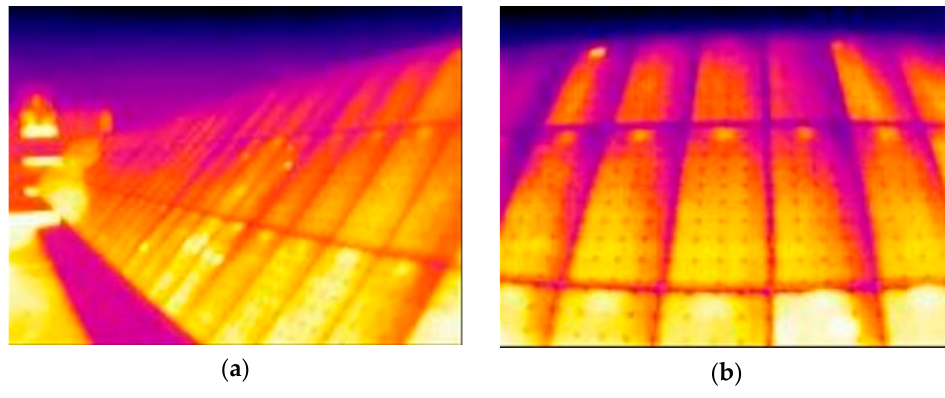
Figure 19. Sample distance-resolution-distortion relationship based on scene size. ( a ) Large scene image and low distortion. ( b ) Small scene image and high distortion.